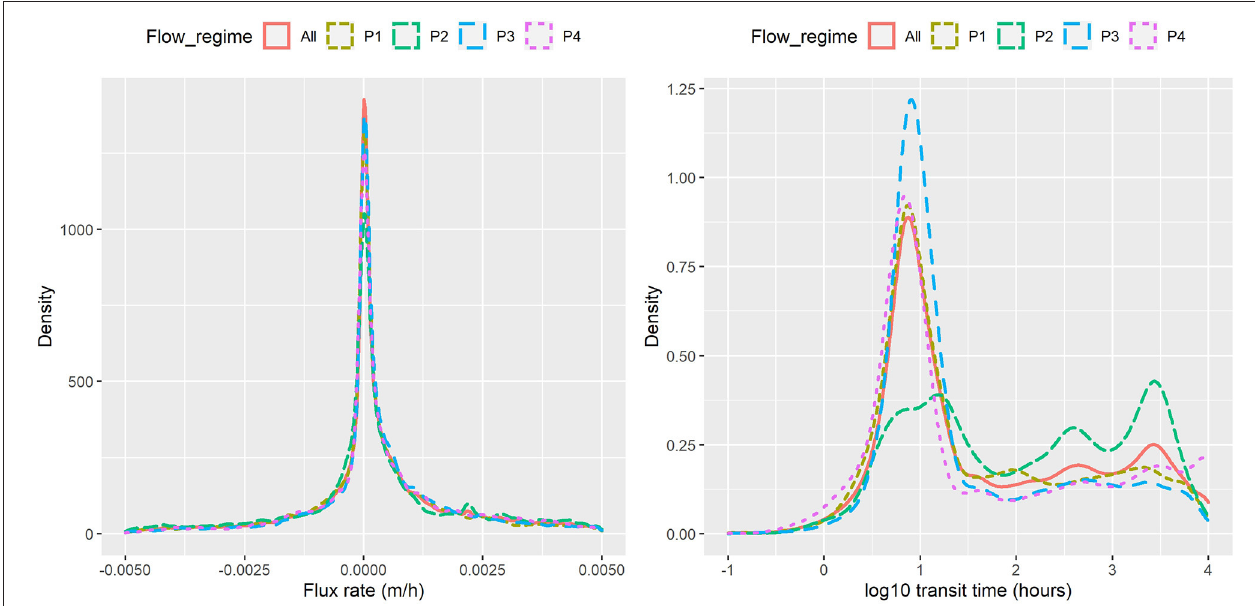
FIGURE 4 | Flux rate and transit time obtained from particle tracking under different flow